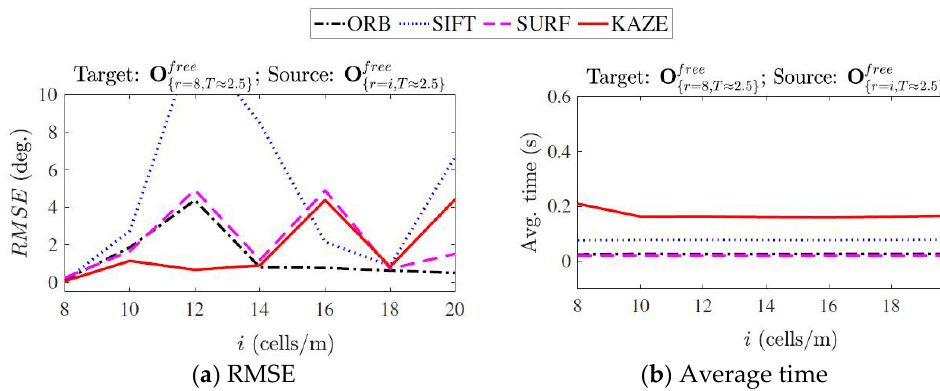
Figure 9. RMSE and average feature matching time for change in resolution computed over 100 runs.